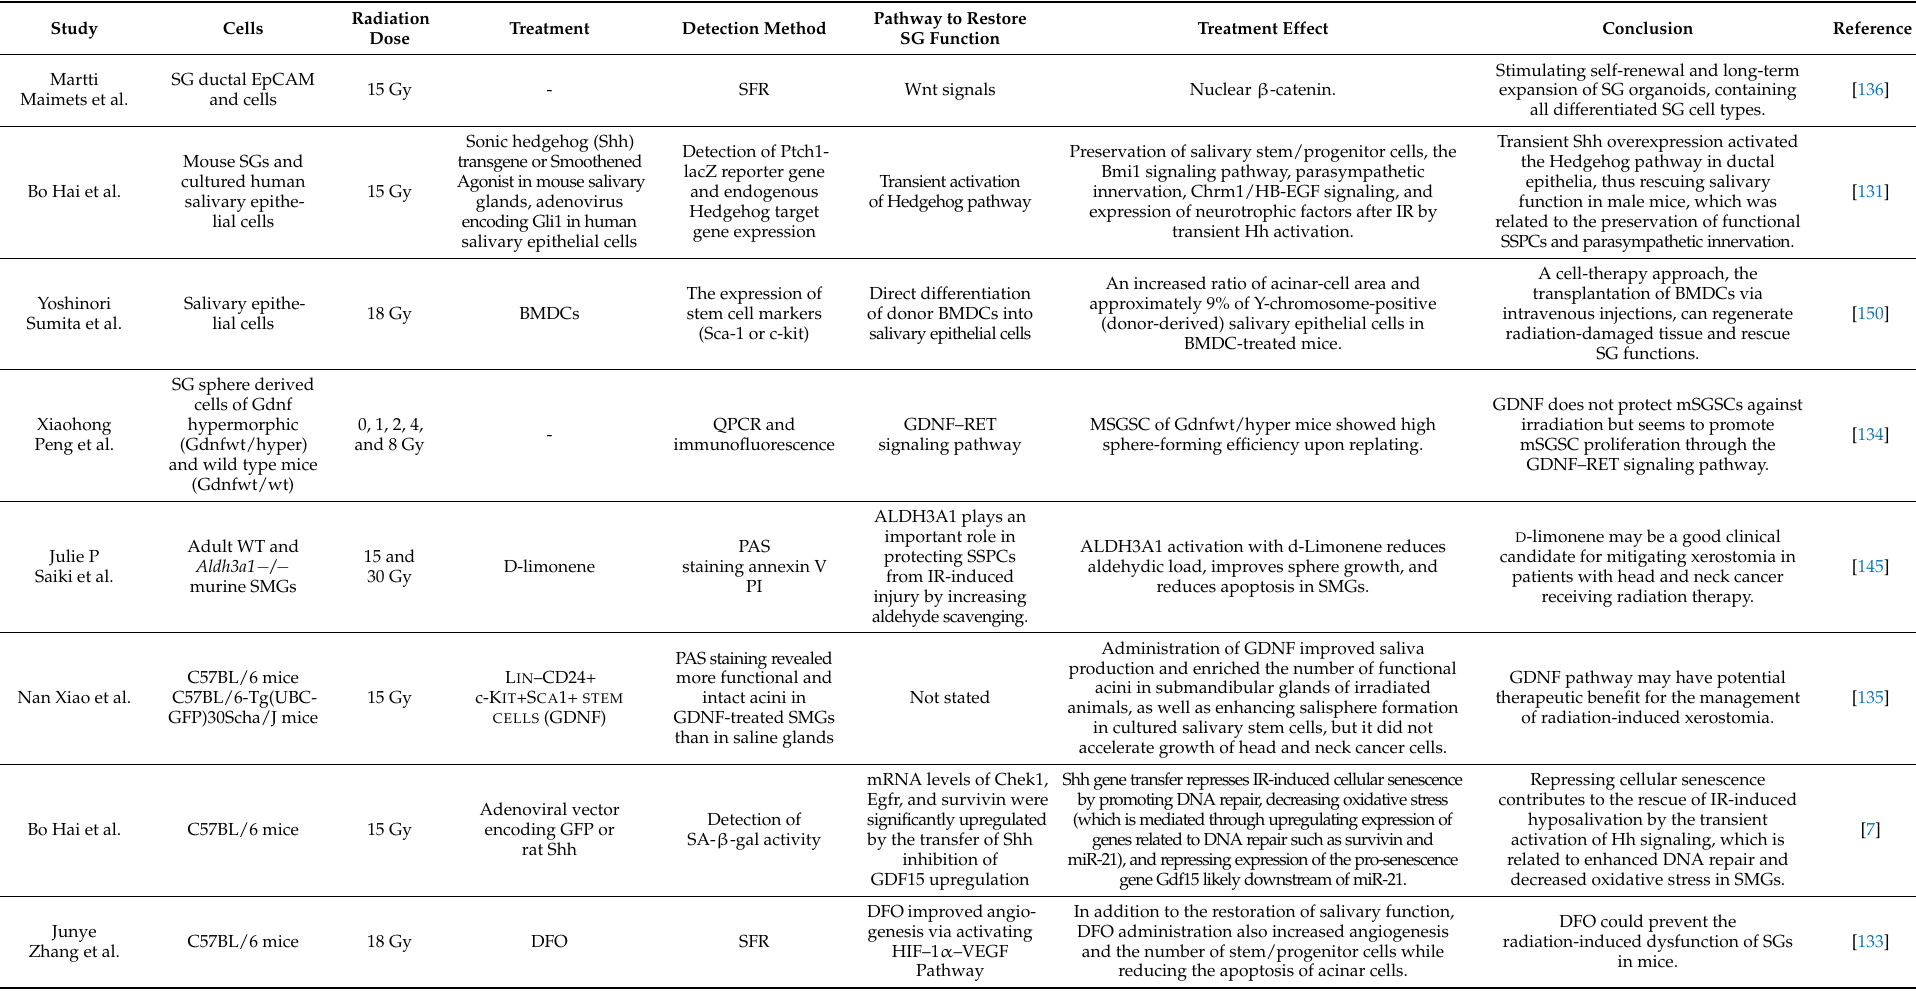
Table 2. Stem cell treatment of radiation-induced SG